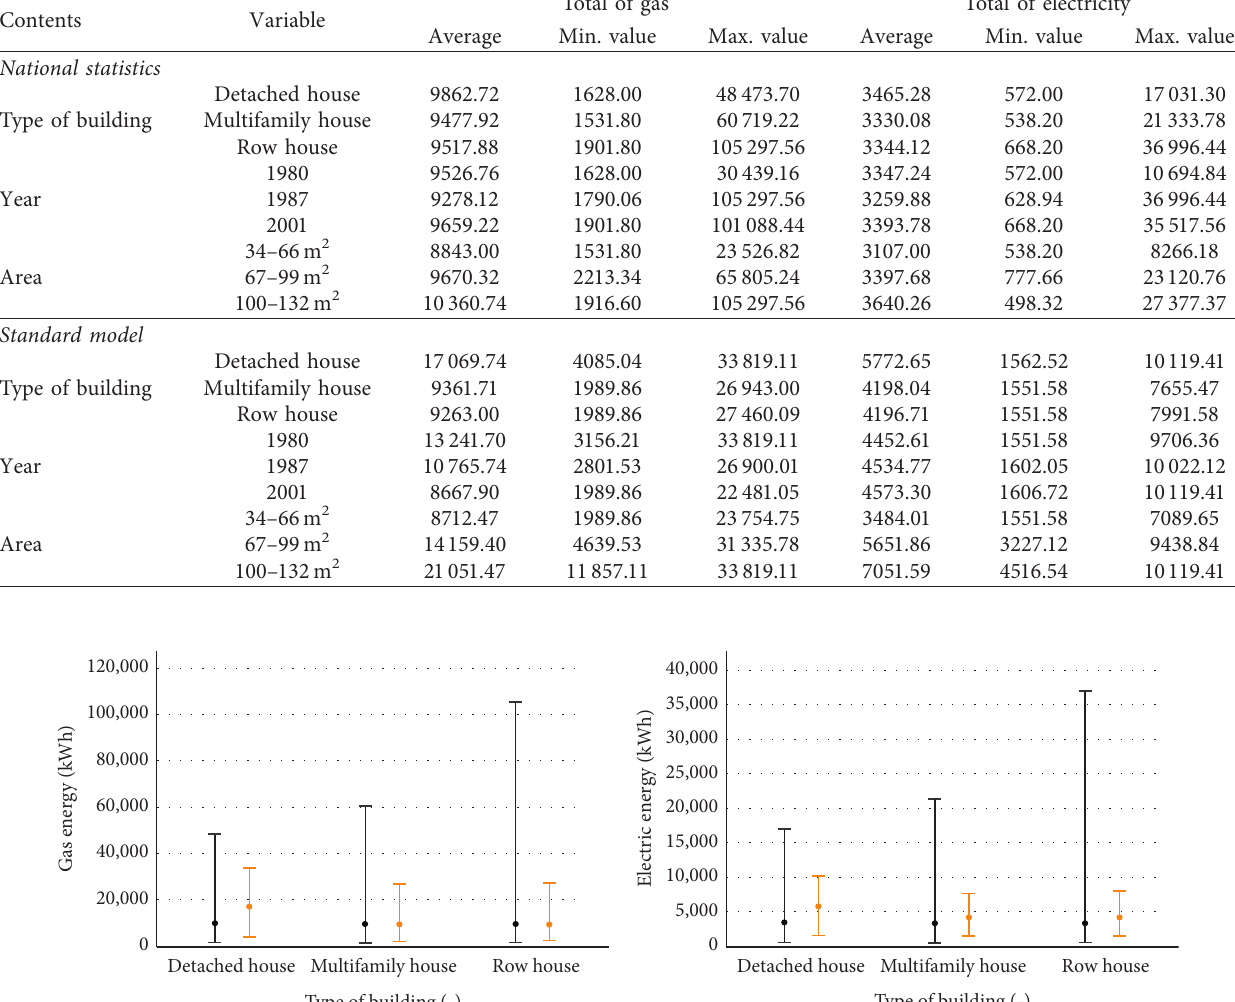
Table 17: Analysis of energy usage comparison: national statistics-standard model